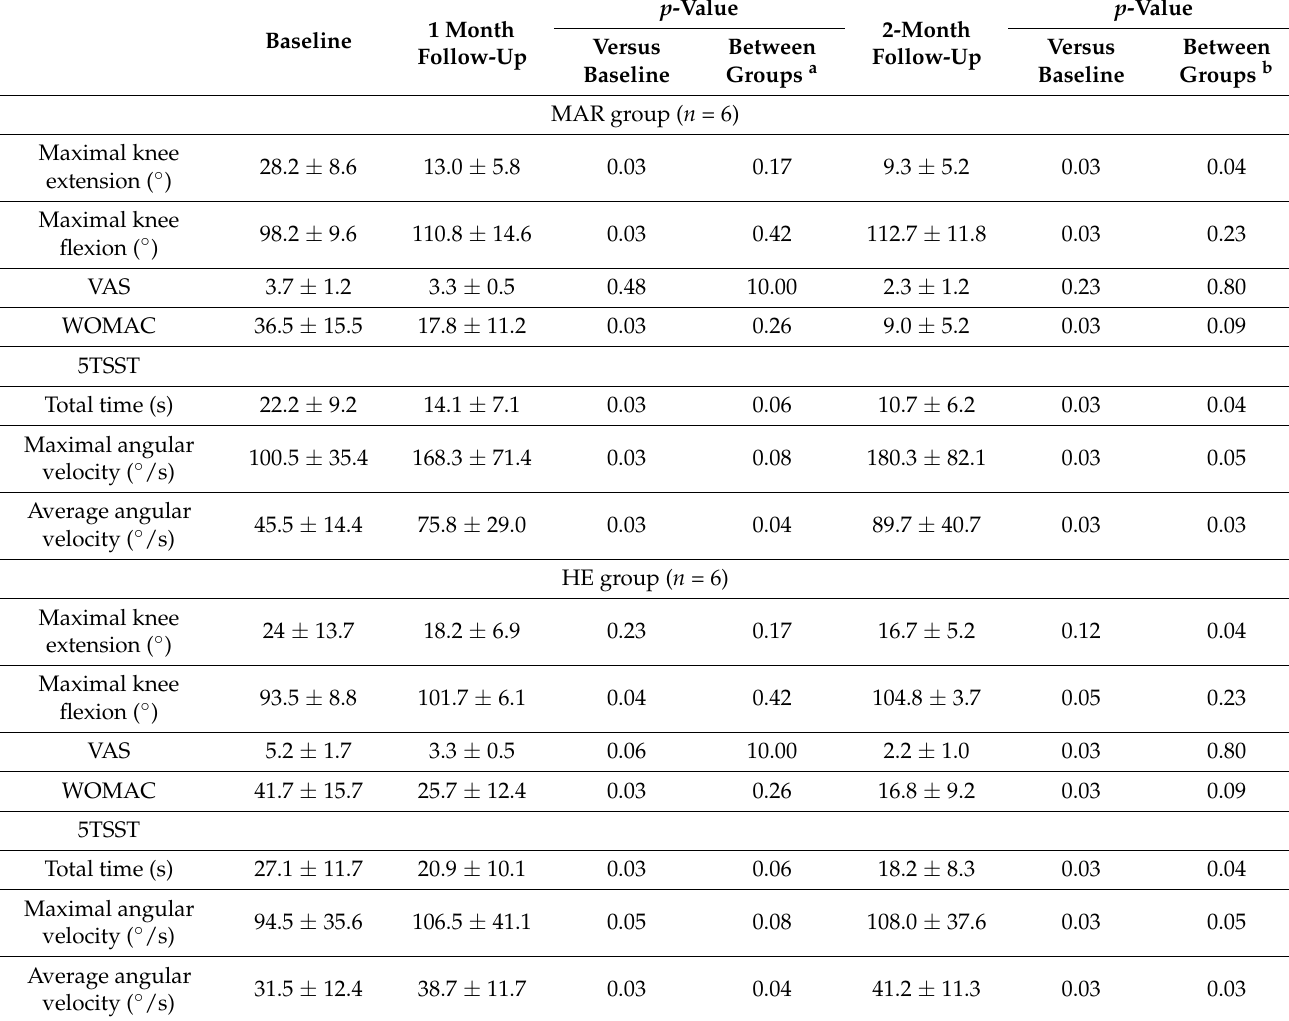
Table 3. Improvements in parameters compared with baseline and between groups.